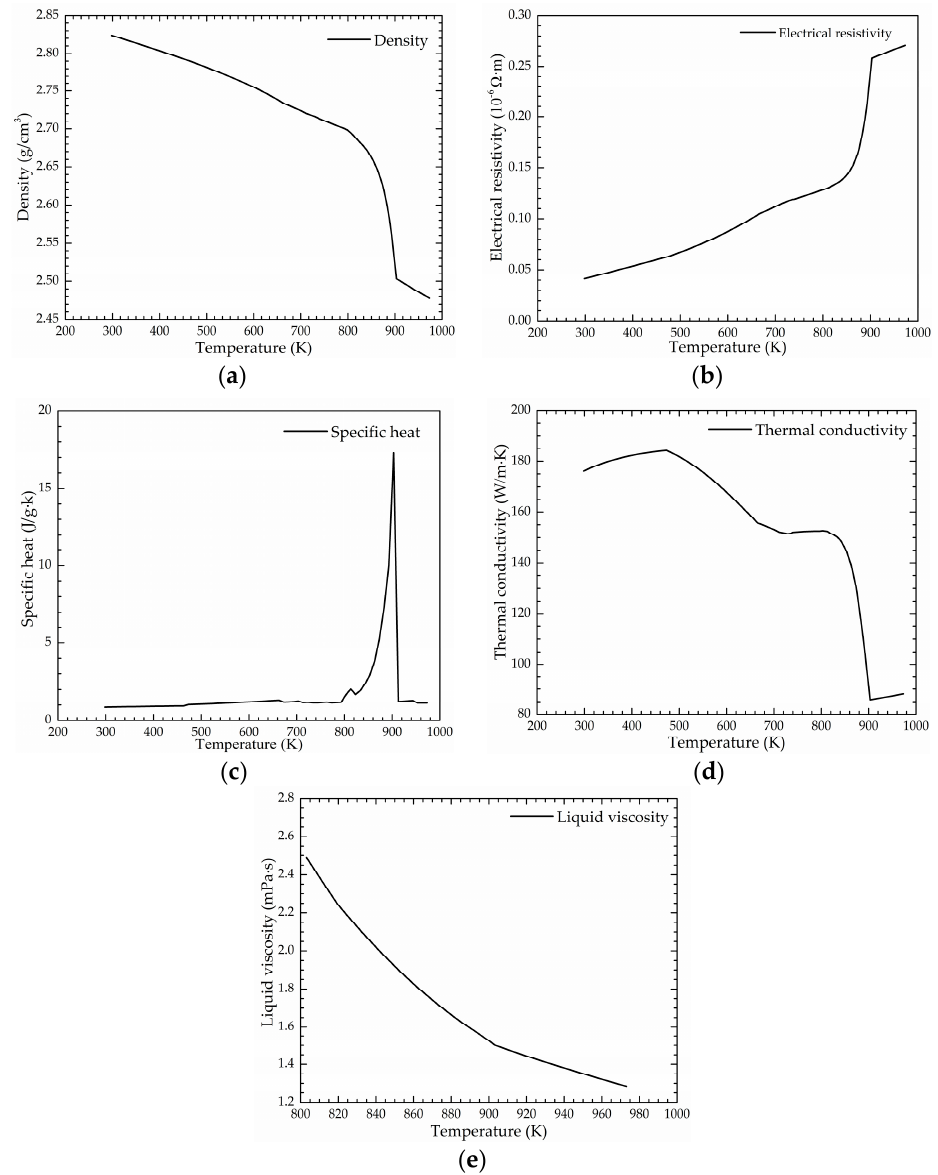
Figure 2. The temperature-dependent physical properties of the 7075 alloy: ( a ) density; ( b ) electrical resistivity; ( c ) specific heat; ( d ) thermal conductivity; ( e ) liquid viscosity.